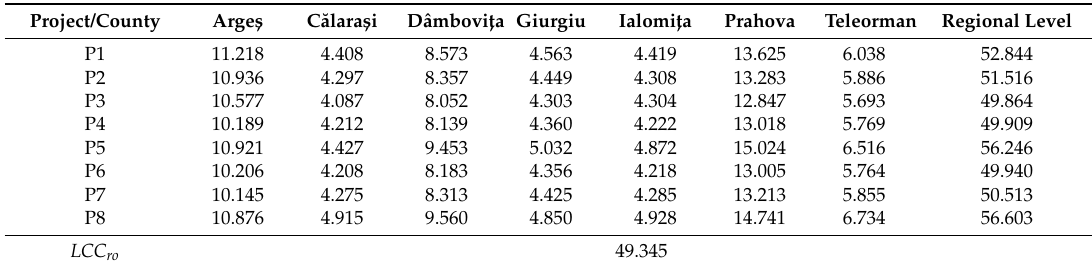
Table A2. LCC at the regional level for the average scenario (billions euro).